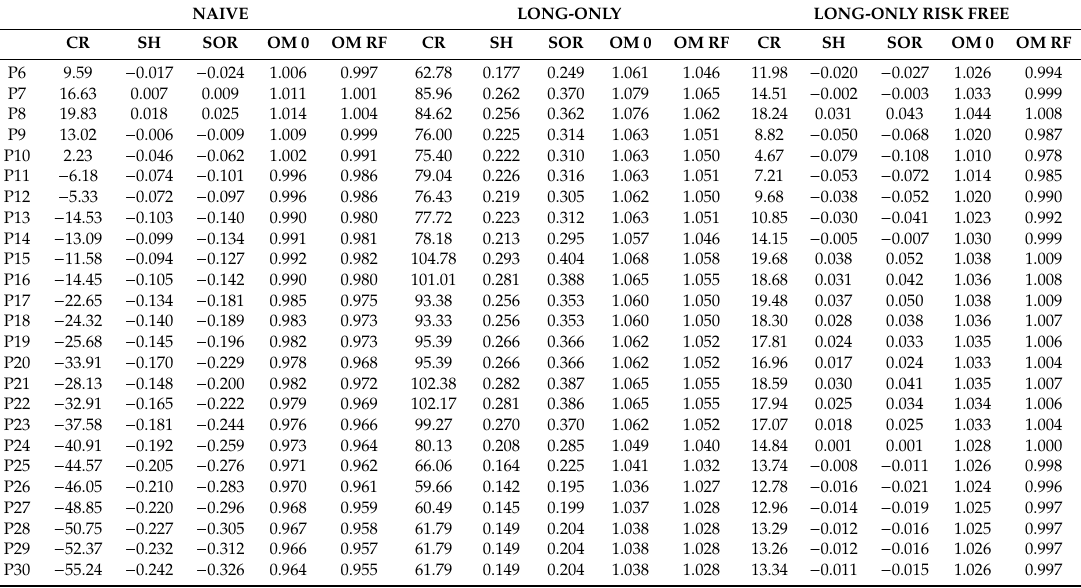
Table 11. Performance from vice portfolios using a 3-year rolling window considering transaction